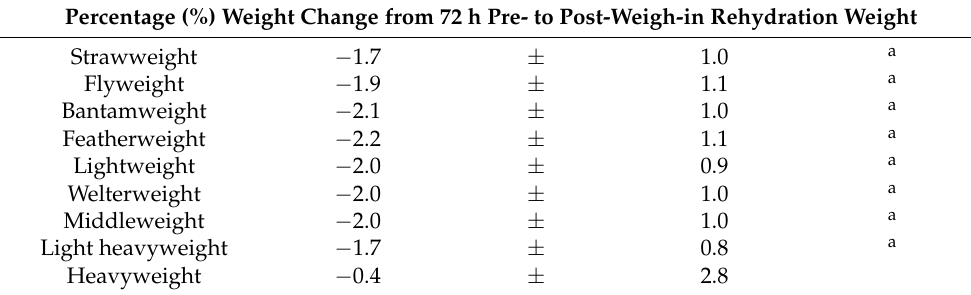
Table 2. Percentage Weight Changes by Weight Class (Fixed Effects).